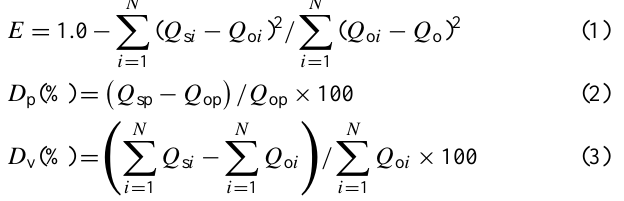
Results of calibration and validation showed that the sim- ulated flow compared well with observed values. The cali- brated models were validated for flow prediction in the Xi- aoqing